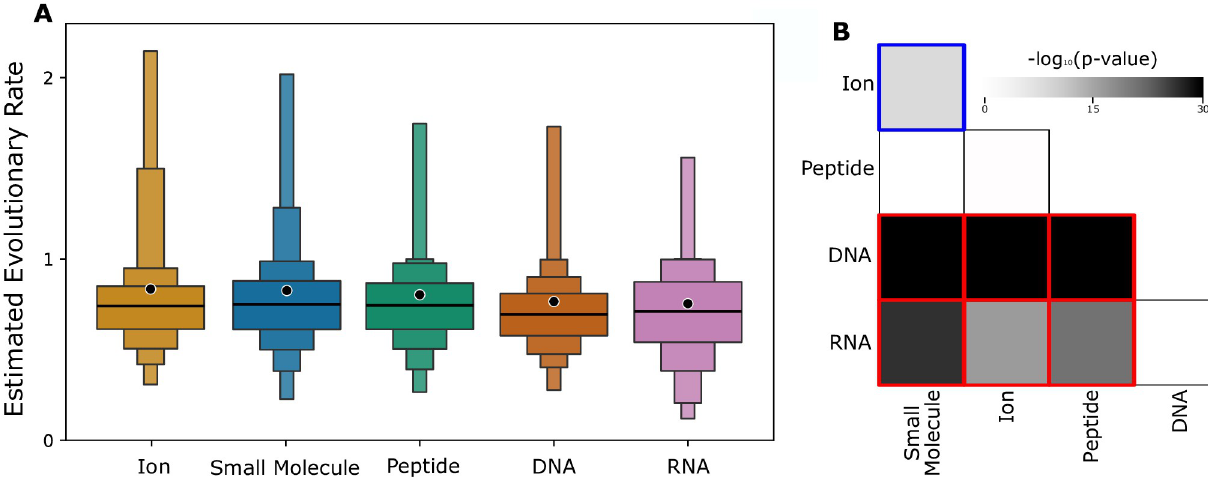
Fig 2. Relative evolutionary patterns of ligand-binding sites. (A) Letter-value (or boxen) plots of the estimated evolutionary rates computed by Rate4Site for sites that bind each of the five ligand types. In letter-value plots, the widest box shows half the data (from the 25th to 75th percentiles), while each successively narrower box shows half the remaining data. In the middle box for each ligand type, median values of estimated evolutionary rates are shown with a black line and mean values are shown with a black dot. Four letter-values (boxes) are plotted for visual clarity, in order of mean evolutionary rate (left to right). (B) Pairwise significance comparisons (Bonferroni corrected -log10(p-values), see ‘Materials and Methods’ section) of each ligand class are shown in greyscale, with outlined colored directional comparisons indicating if the ligand class on the bottom is more rapidly evolving than that on the left (red) or if the opposite is true